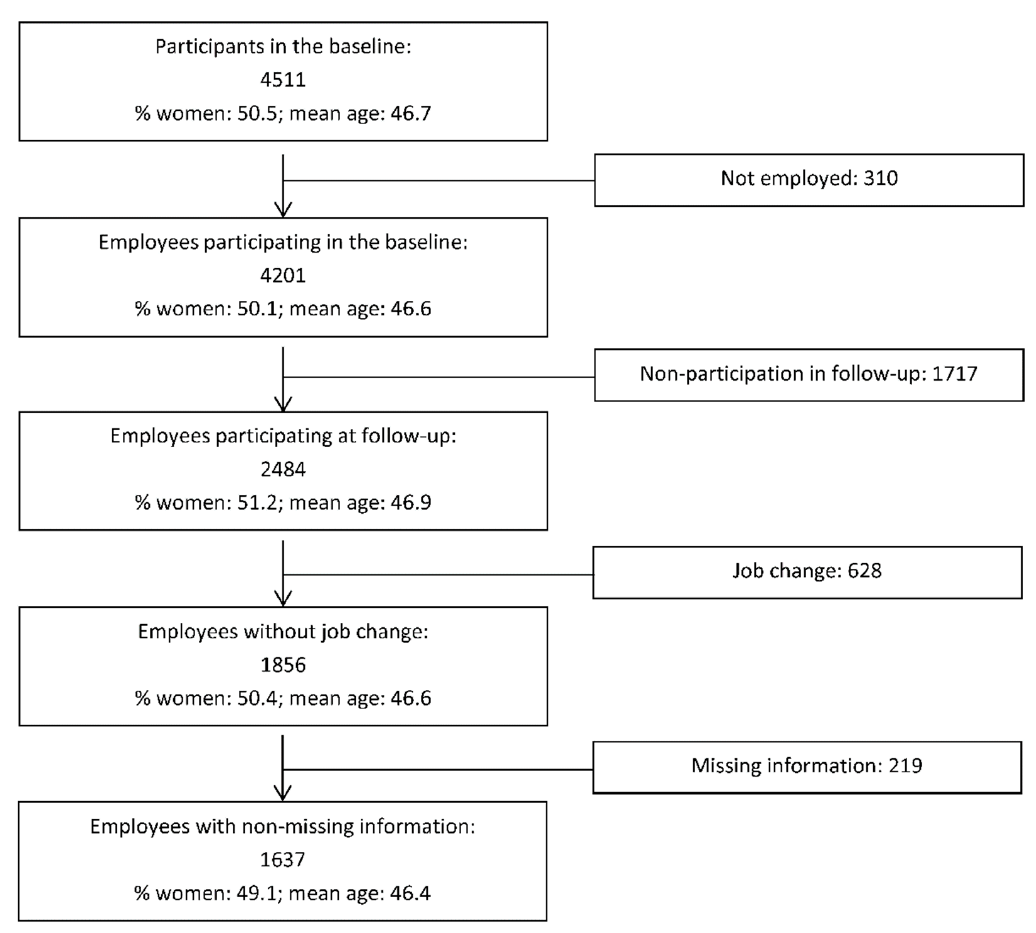
Figure 1. Flow diagram of participation.